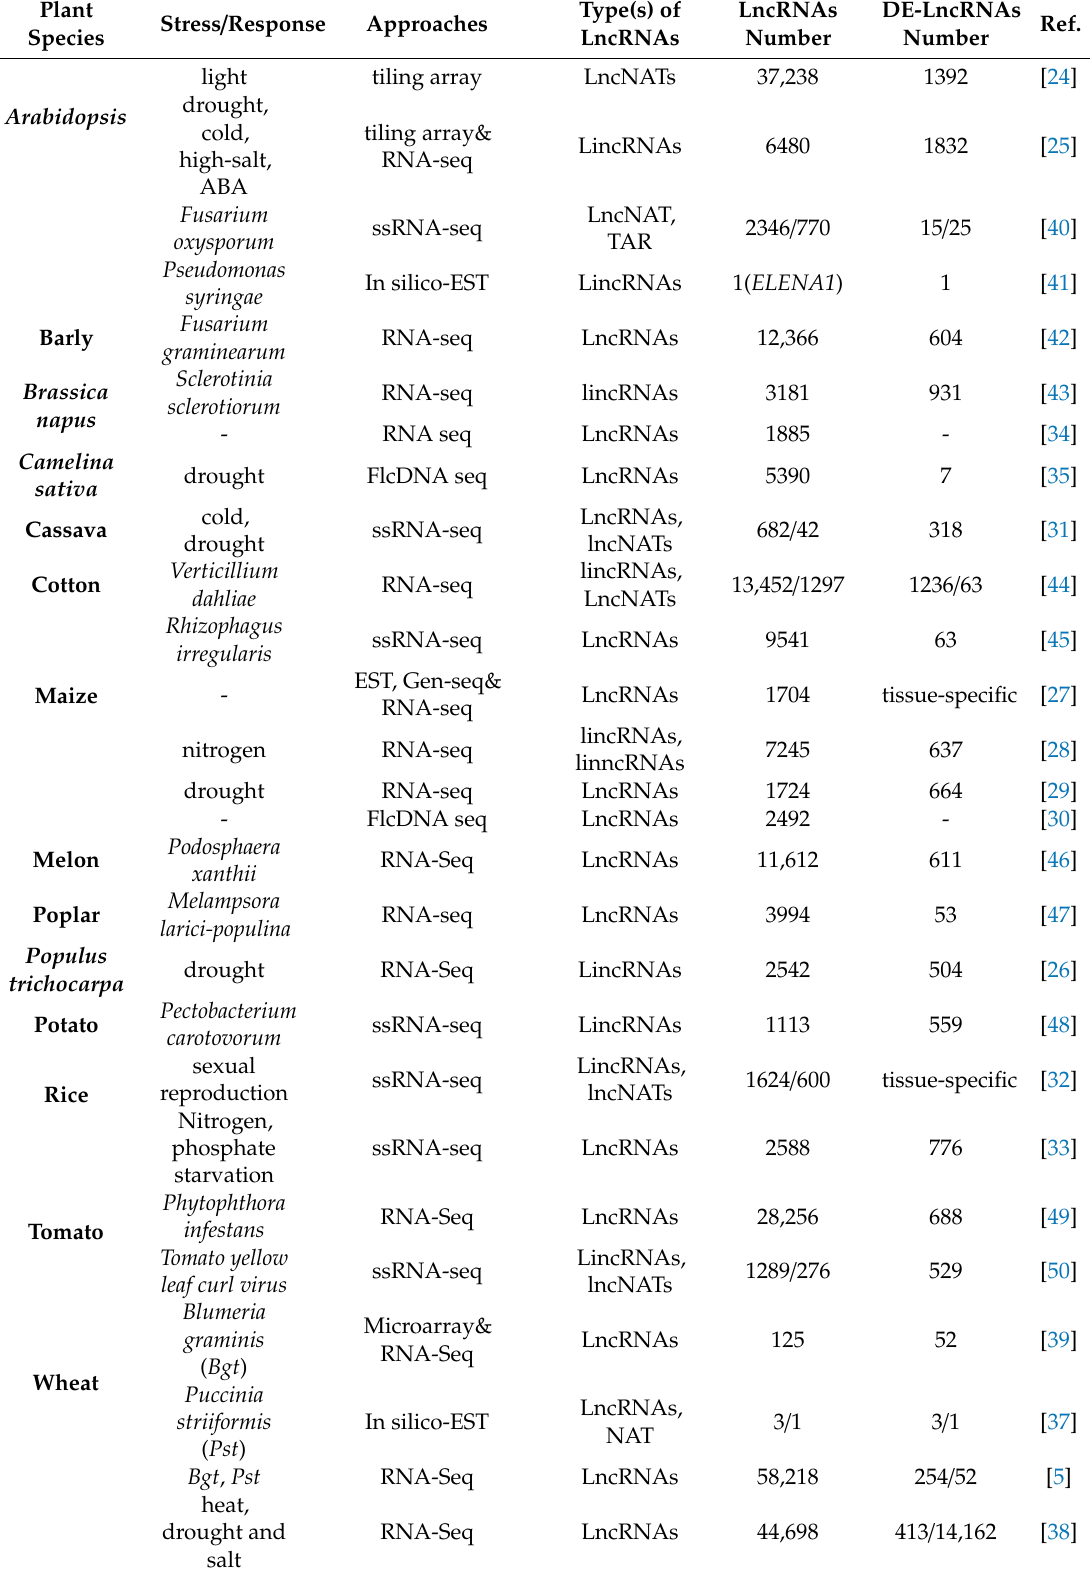
Table 1. List of long non-coding RNAs (lncRNAs) identified in plants under fungal pathogen stress.